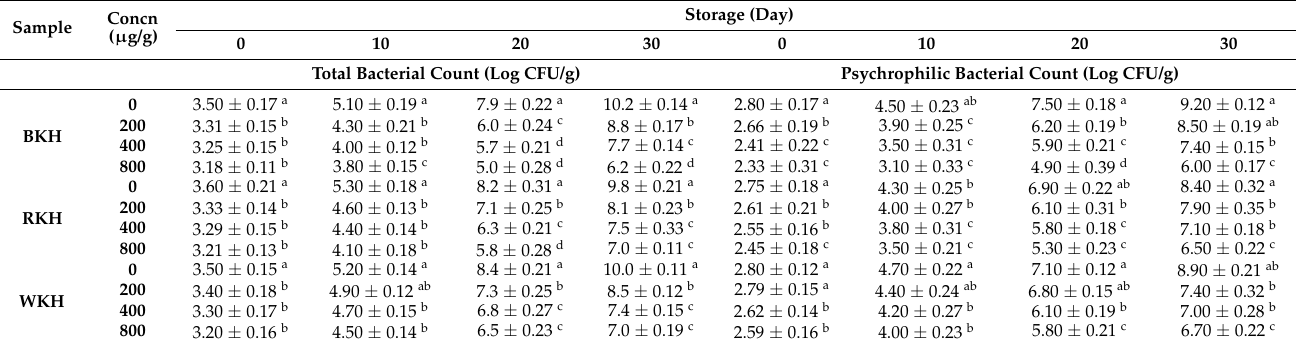
All values are expressed as the means ± SD. Means with different lowercase letters in the same column indicate significant differences at p ≤ 0.05 by